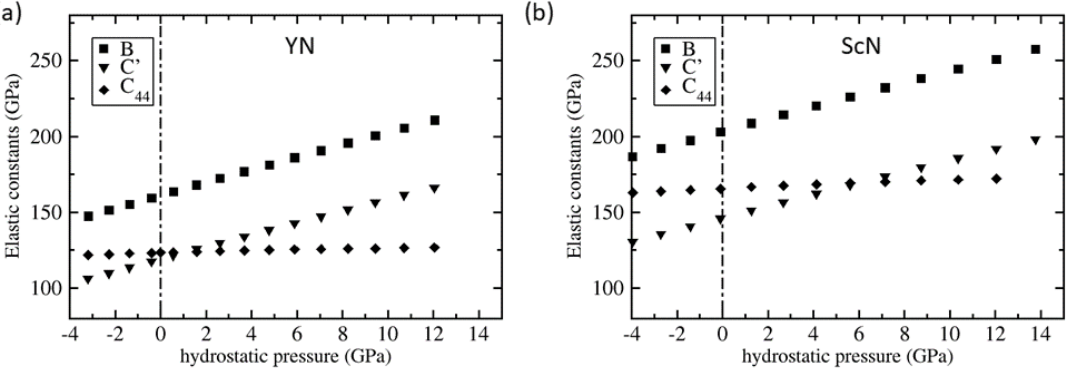
Figure 4. Quantum-mechanically calculated second-order elastic constants of YN ( a ) and ScN ( b ) for different hydrostatic pressures. The vertical dash-dotted lines indicate the zero hydrostatic pressure.